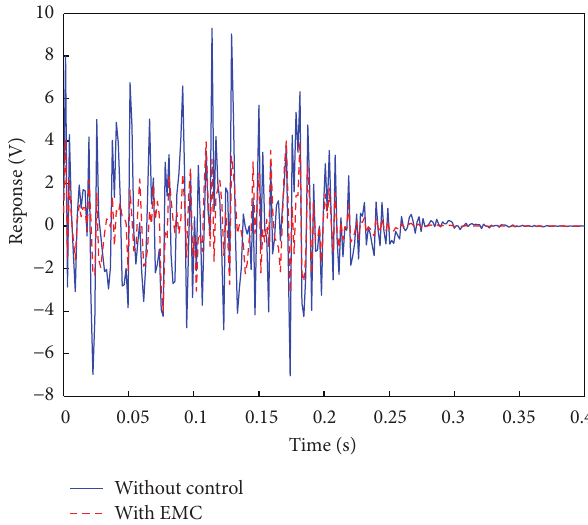
Figure 9: Vibration response at the midpoint of the first link.